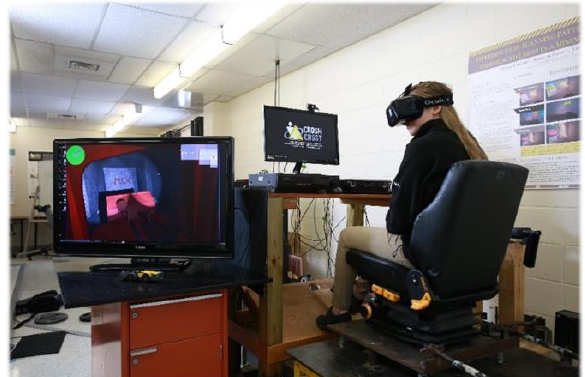
Figure 1. User with virtual reality (VR) headset navigating on load-haul-dump (LHD) machine in the virtual mine environment .